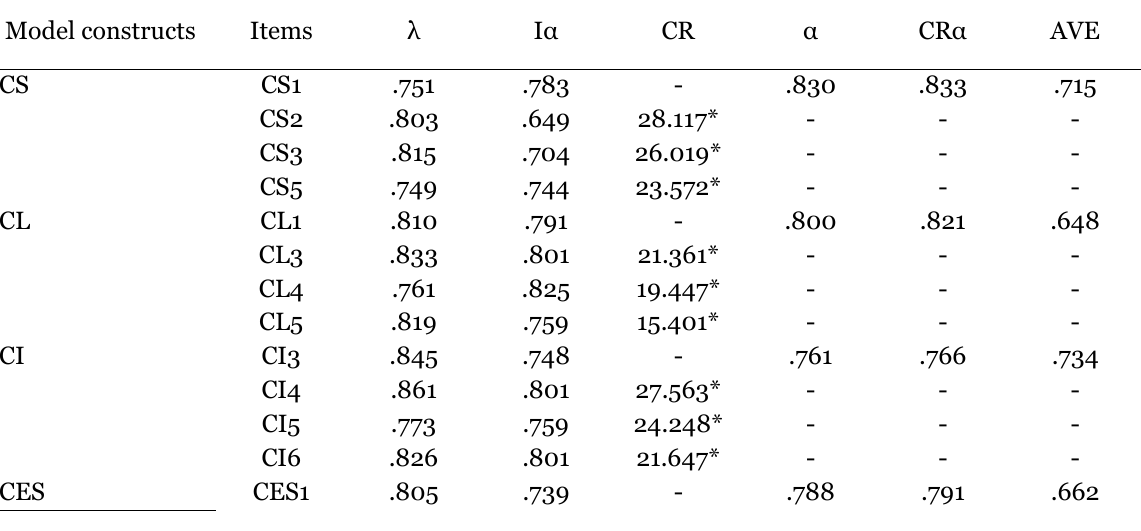
Convergent Validity Measurement Model